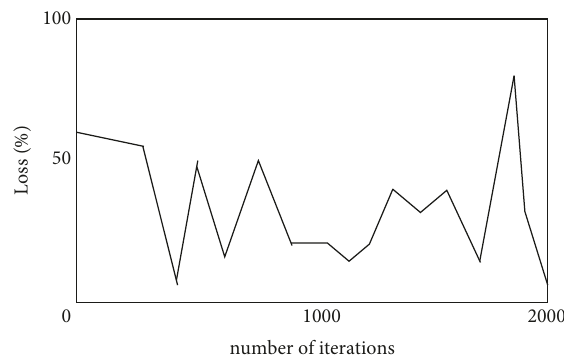
Figure 8: Multiresource pool training